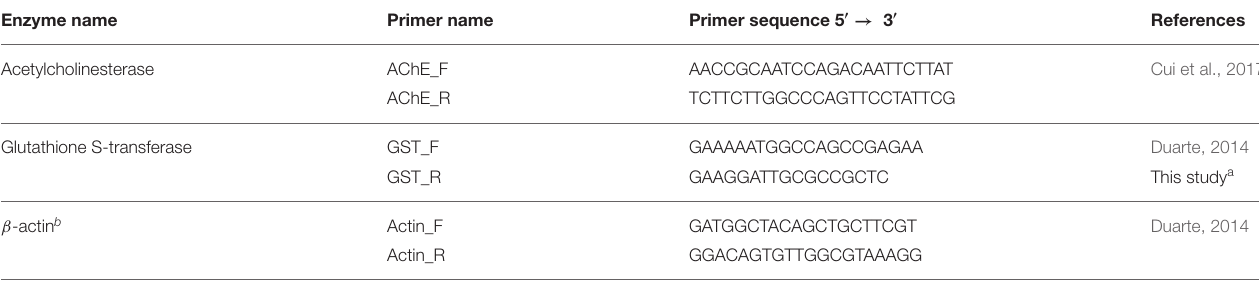
TABLE 1 | Primer sets used in the